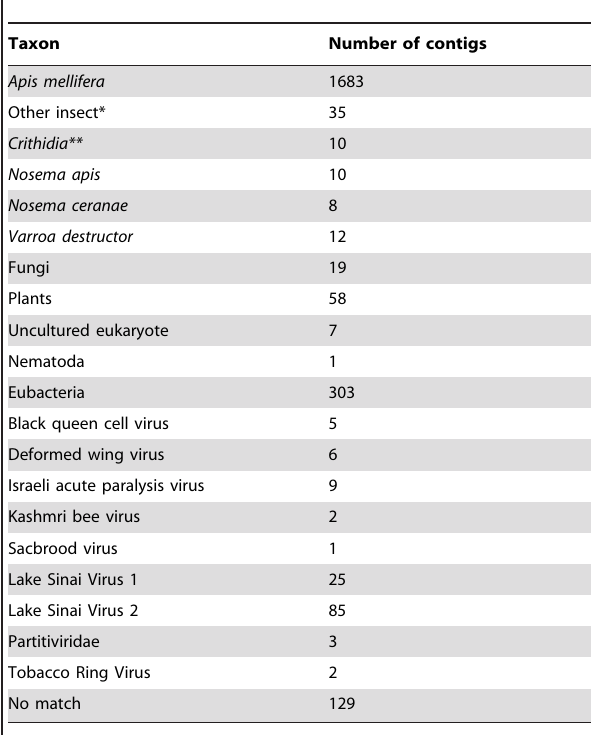
Table 6. Best BLAST match of contigs assembled from deep sequencing of the CCD + and CCD 2 cDNA libraries derived from pooled colony samples of total RNA.